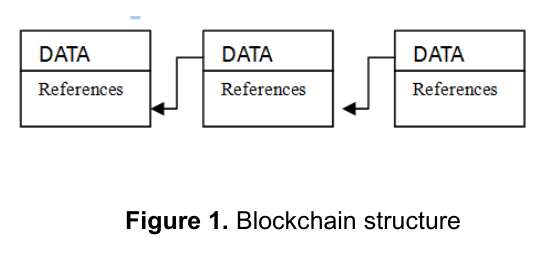
Figure 1. Blockchain